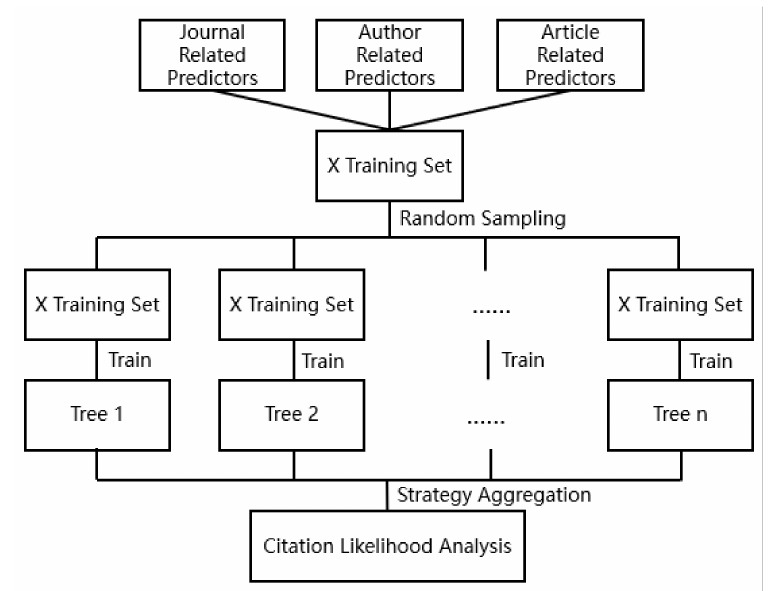
Figure 3. Random forest citation likelihood analysis